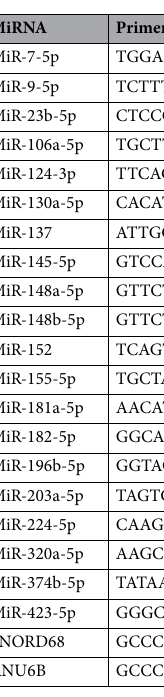
Table 1. Primer Sequences of circulating miRNAs